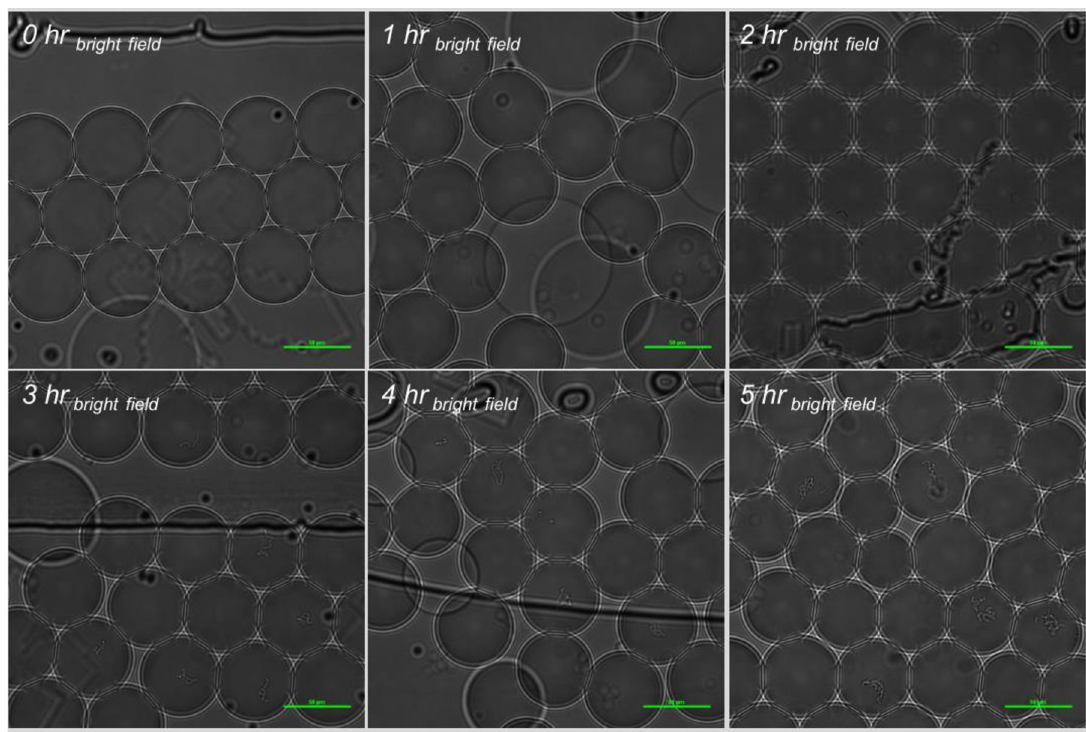
Fig 9. Bright field images of S . Typhimurium incubation in-droplet with 0.5x shredded lettuce wash water, and 10 μ g/ml FITC-Ab in 1x RV broth at 37˚C.